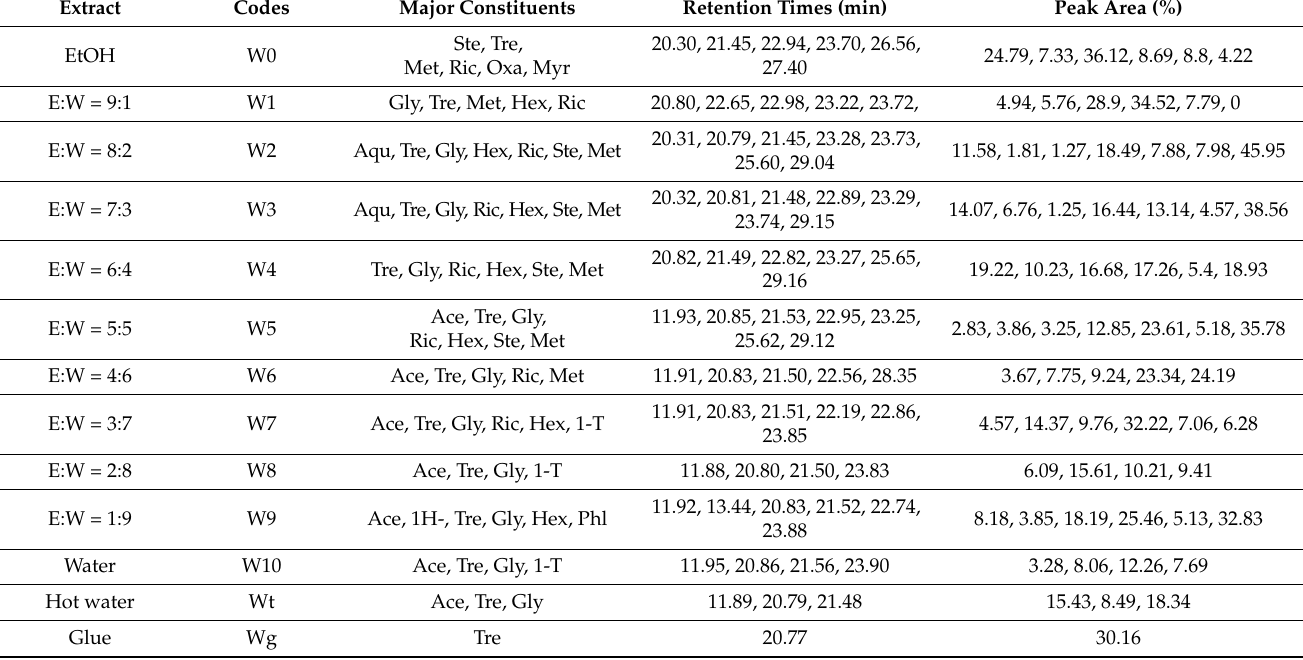
Table 3. Principal compounds identified in Cordyceps militaris SBRs by GC-MS screening